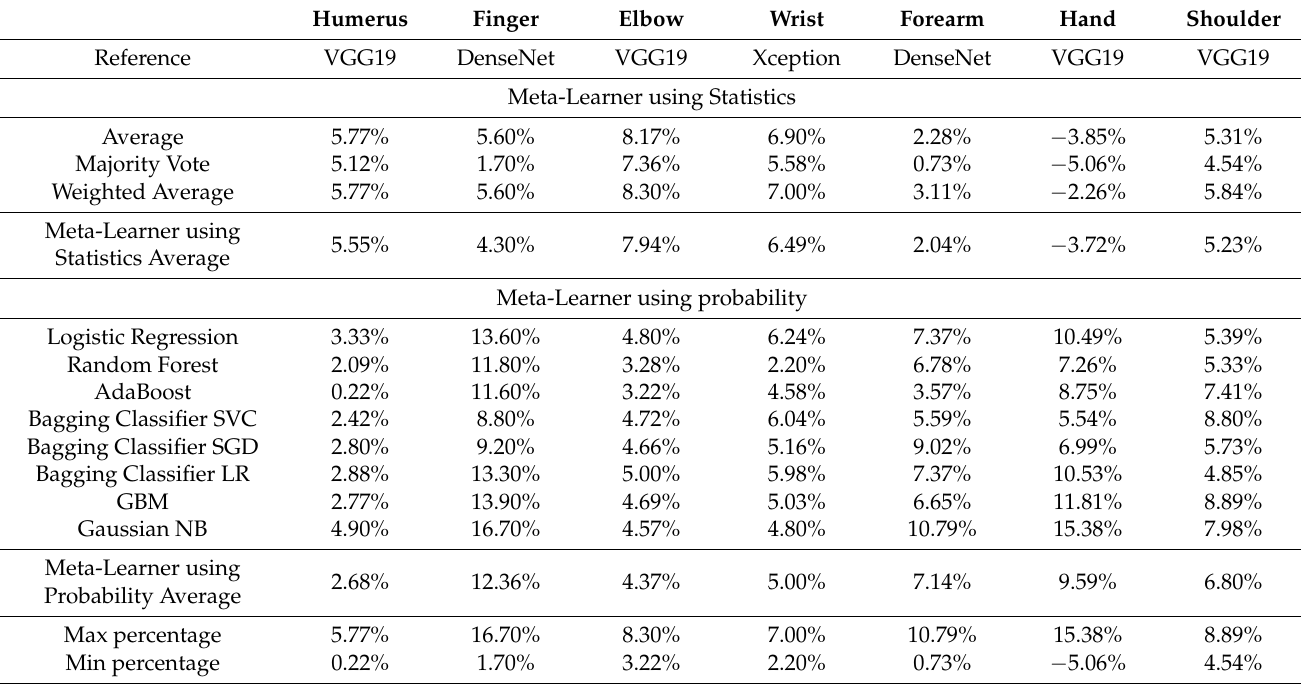
Table 2. Difference between the percentage values of the Kappa score of the highest level-0 classifiers (CNNs) and the Kappa score of the level-1 classifiers (machine learning